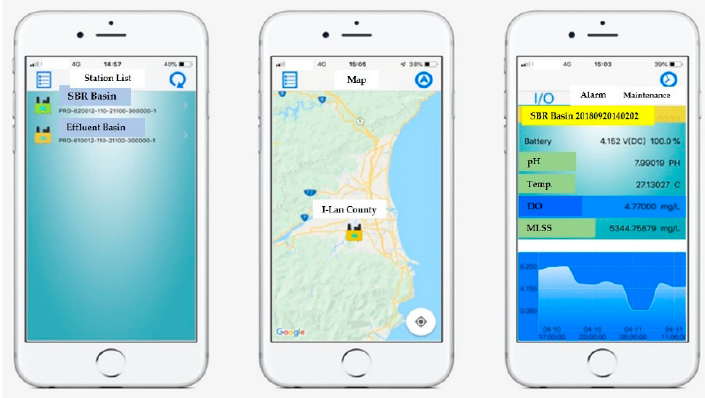
Figure 8. The appearance of the AQWEB software app.